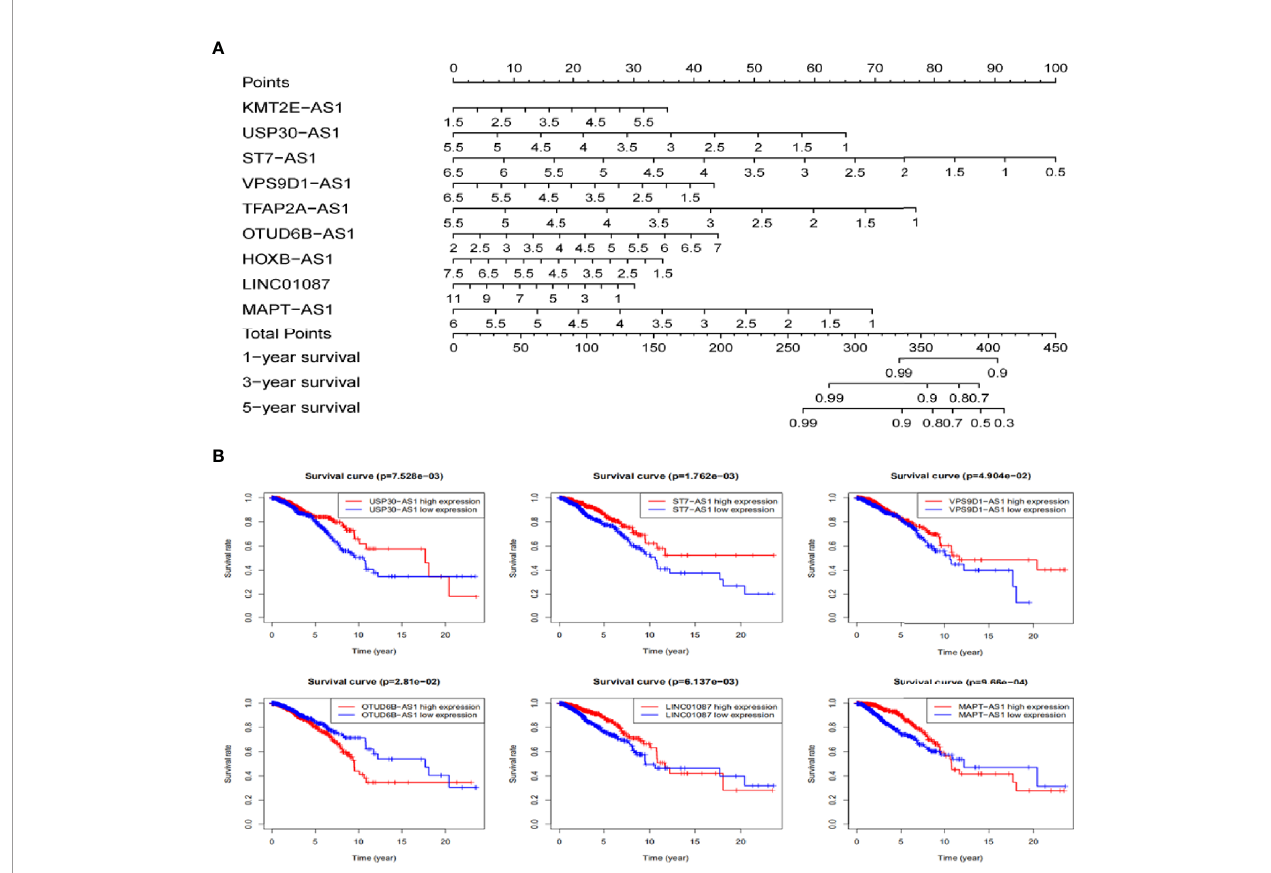
FIGURE 8 | The nomogram establishing and the prognostic value validating base on 9 lncRNAs in TCGA dataset. (A) Establishment of a nomogram for 1-, 3-, and 5-year OS prediction in breast cancer. (B) Validation the prognostic value of these 9 autophagy-related lncRNAs in breast cancer by Kaplan Meier- plotter